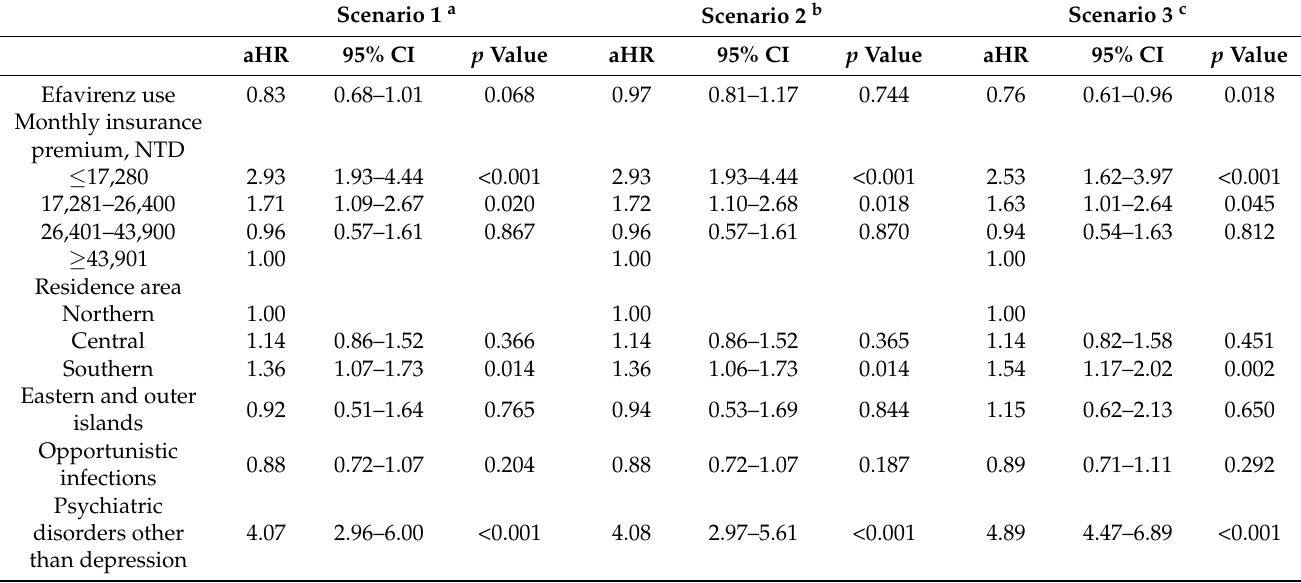
Table 3. The sensitivity analyses according to three